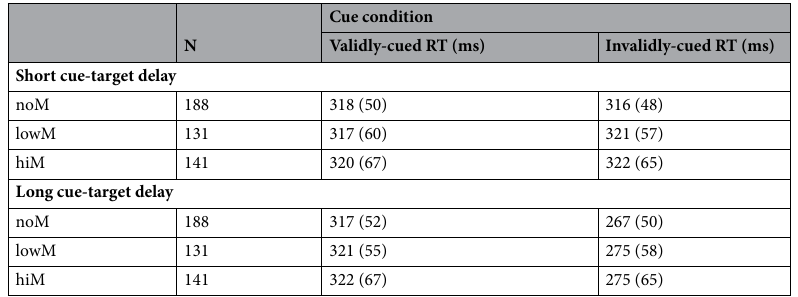
Table 3. Mean reaction time across subjects for the attentional cuing task (flash cue) in Study 1, as a function of cue condition, cue-target delay, and MkAQ scores (noM = a sum score of 0 or 1 lowM = a sum score of 2–5, hiM = a sum score of 6 or higher). Total participants (N) in each group. Mean values, with standard deviations in